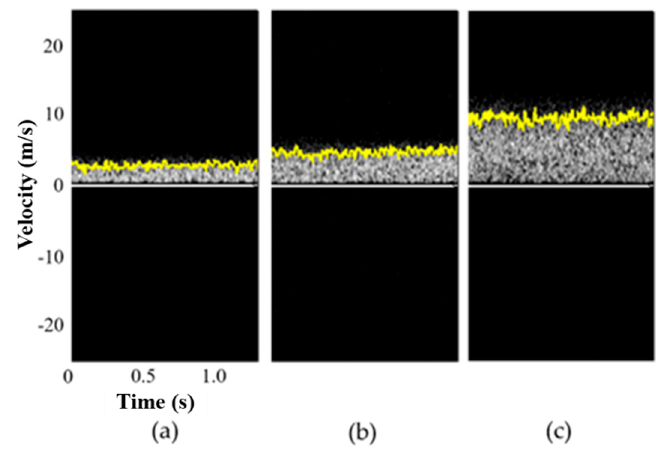
Figure 2. Measured flow velocities using pulsed wave spectral Doppler imaging acquired from the flow phantom with velocities of ( a ) 3, ( b ) 5, and ( c ) 10 cm/s. The measured average velocities for each case were, respectively, 2.9 ± 0.4, 4.9 ± 0.5, and 9.9 ± 0.7 cm/s.